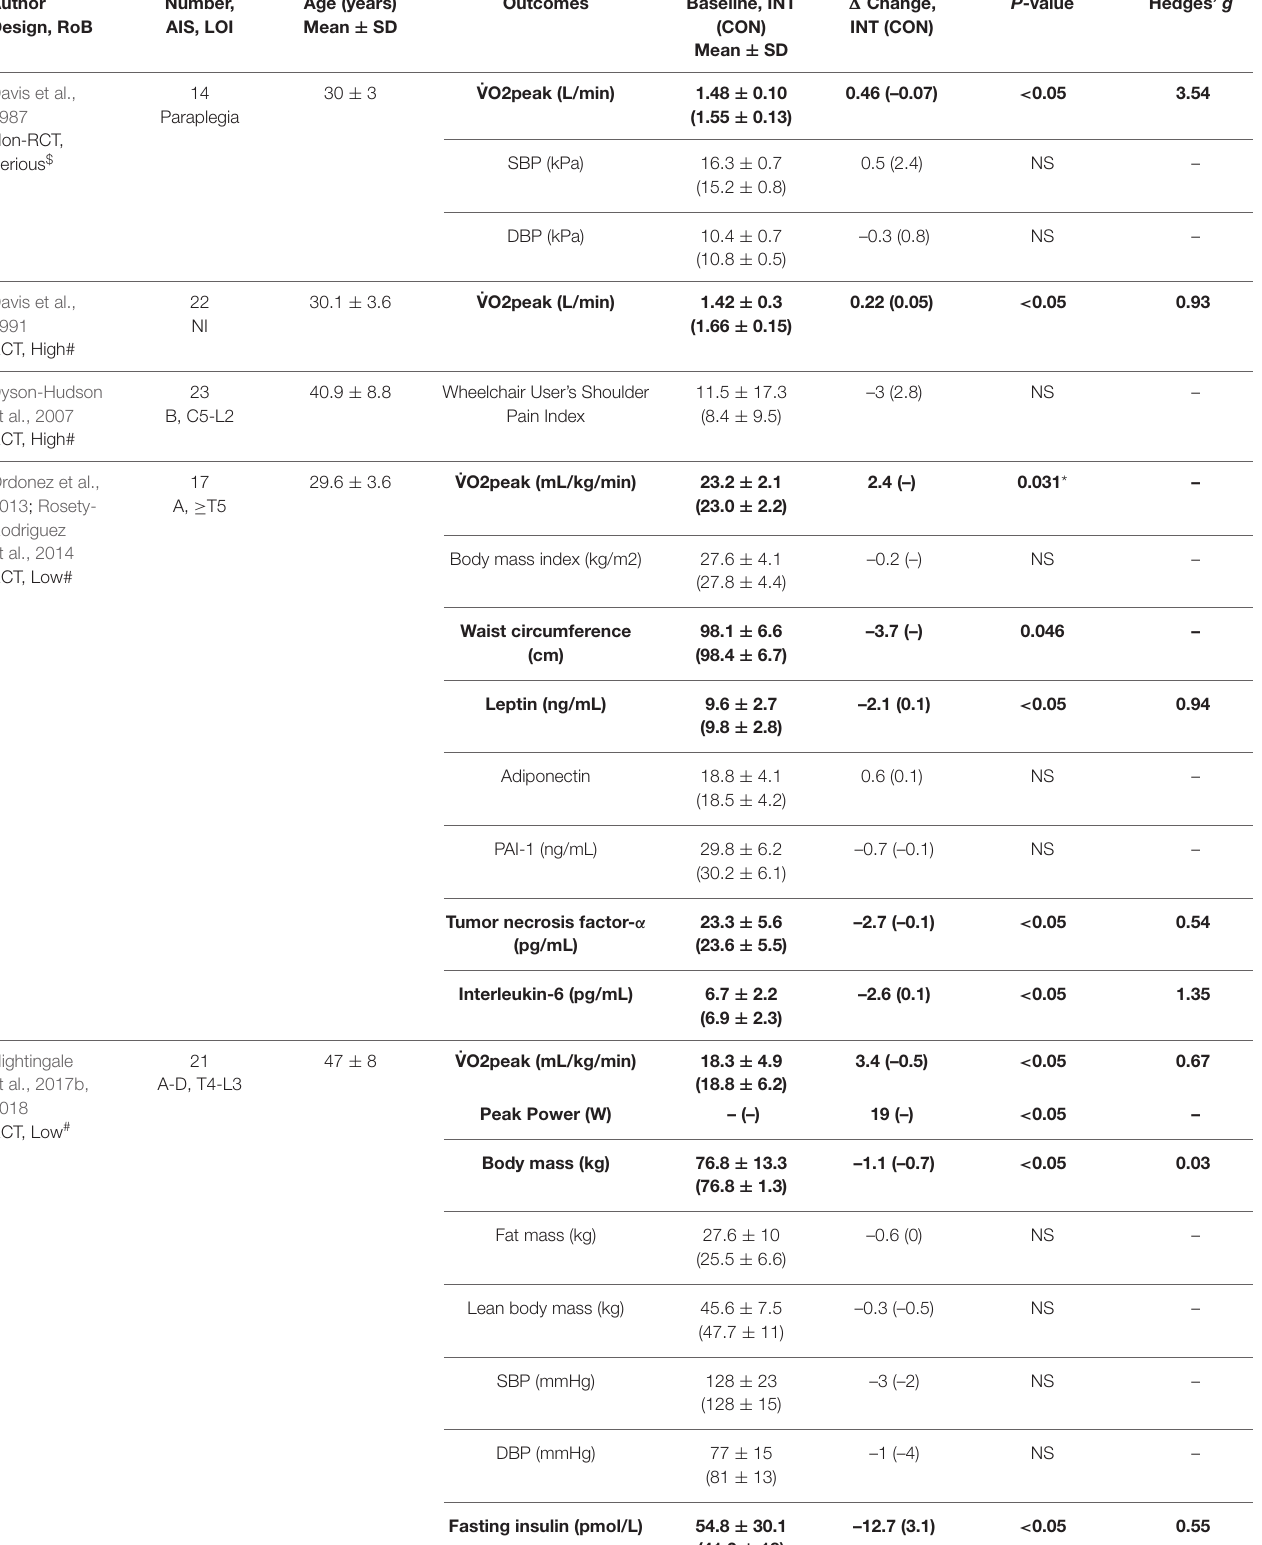
TABLE 1 | Detailed findings from specific studies with a control group in the systematic